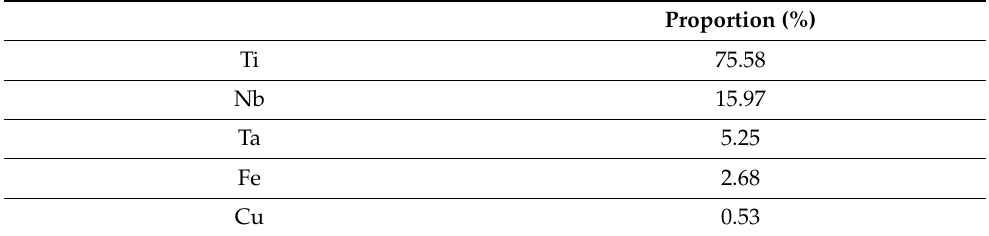
Table 1. Proportion of each element in the laser cladded